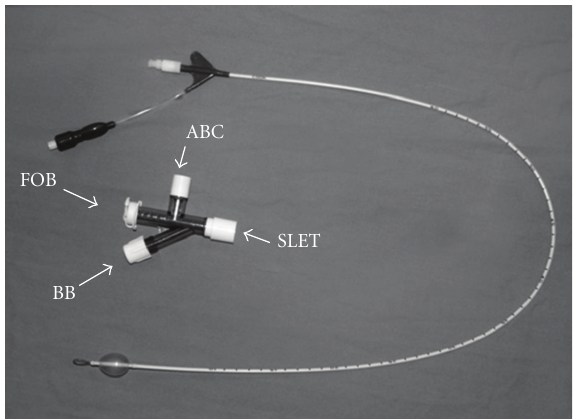
Figure 1: displays the Arndt